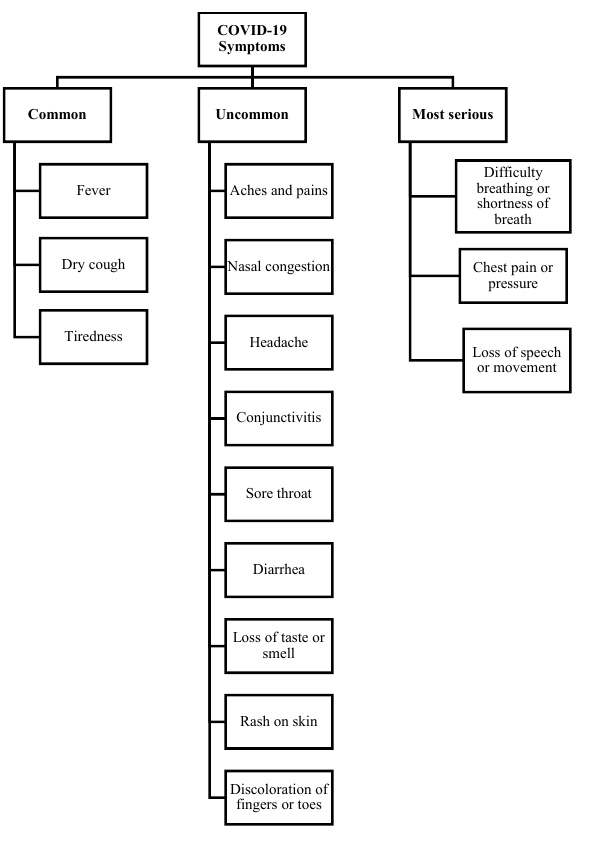
Figure 9. COVID-19 Symptoms.